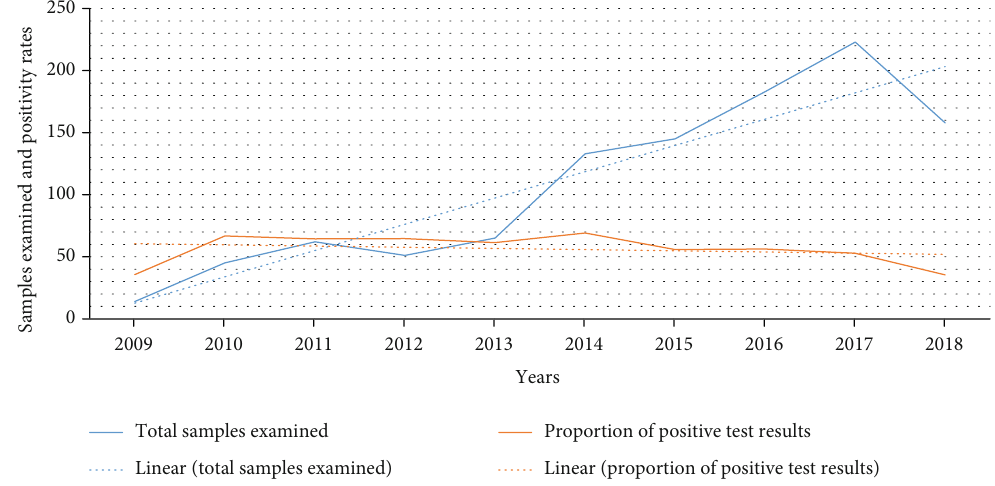
Figure 1: Trend for CL suspected and proportion con fi rmed cases in LRTC at University of Gondar, Northwest Ethiopia, 2009-2018. Table 1: Age- and sex-related patterns of CL prevalence in LRTC, University of Gondar, Northwest Ethiopia (2009-2018). Variables Chi-square